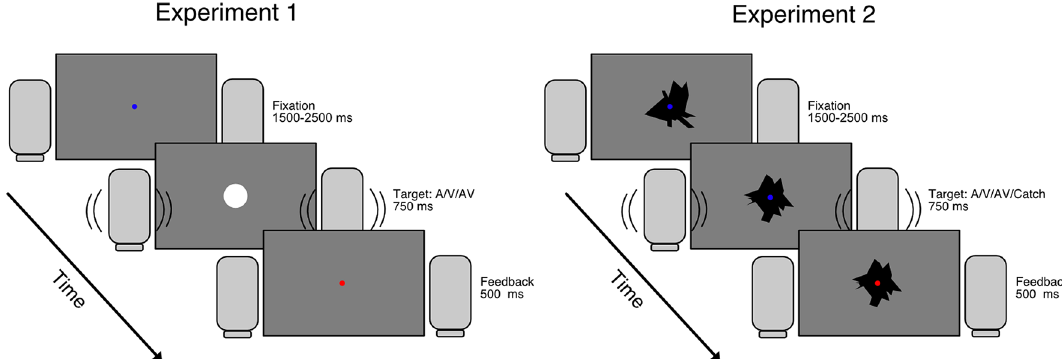
Figure 1. Schematic depictions of an audiovisual trial in Experiment 1 and